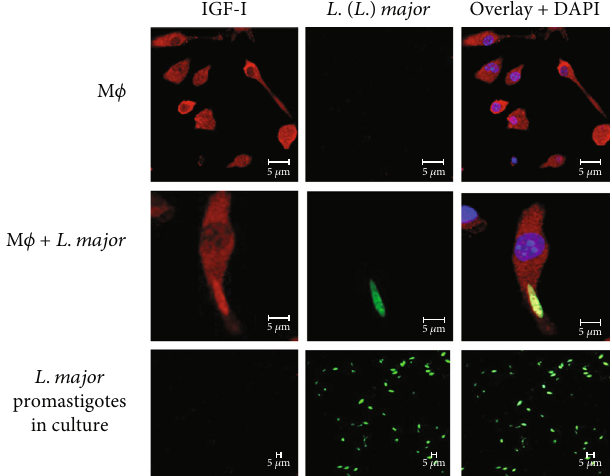
Figure 4: Detection of IGF-I within RAW 264.7 macrophages following infection with Leishmania major promastigotes. Colocalization of IGF-I and Leishmania was analyzed using immuno fl uorescence. Following a 24h in vitro infection, cells were fi xed in 4% paraformaldehyde (Sigma-Aldrich, USA), washed in 0.01M phosphate-bu ff ered saline, pH7.2 (PBS), blocked for one hour with 2% bovine serum albumin (BSA; Sigma-Aldrich, USA) in PBS, and incubated overnight with monoclonal goat anti-mouse IGF-I antibody (1 :75; R&D Systems, USA) and a polyclonal mouse anti- Leishmania antibody (1 :400) [136]. Anti-goat IgG Alexa Fluor-546 (1 :200, Invitrogen, USA — shown in red) and anti-mouse IgG Alexa Fluor-488 (1 :400, Invitrogen, USA — shown in green) were used as secondary antibodies. 4,6-Diamidino-2-phenylindole (DAPI, Invitrogen, USA — shown in blue) was used to stain nuclei. Images were captured using a Leica LSM510 confocal microscope with a 63x objective and oil immersion (adapted from Reis et al.